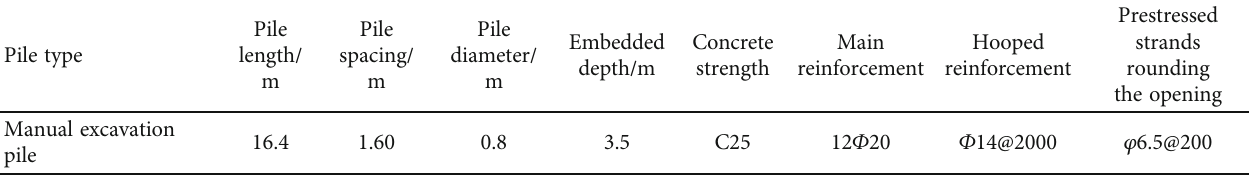
Table 3: Design parameters of slope protection piles.